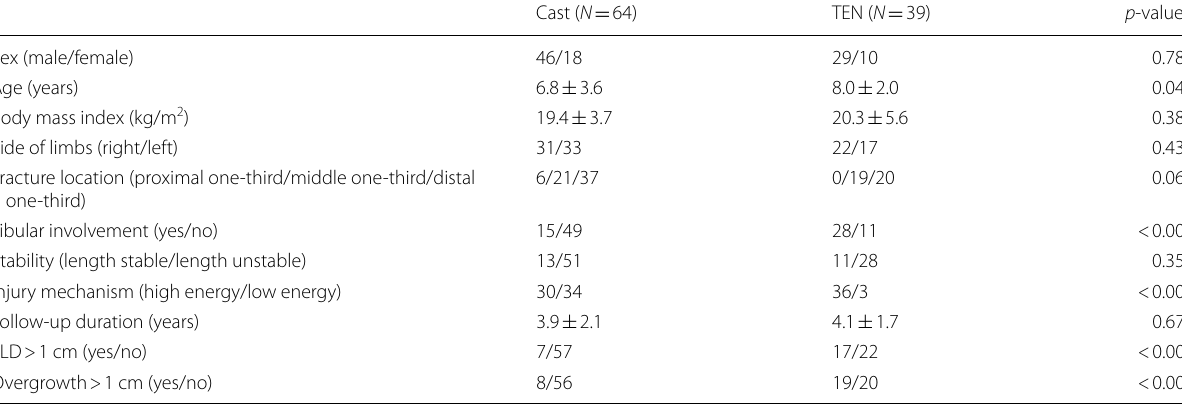
Table 4 Comparison of variables between patients treated by cast and